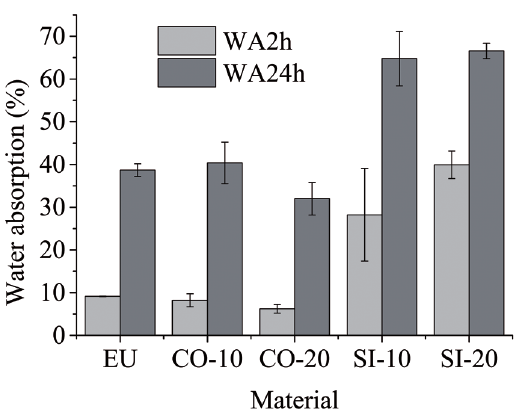
Figure 6: Histogram of the mean values for the water absorption after 2 (WA2h) and water absorption after 24 hours (WA24h). Bars indicate standard